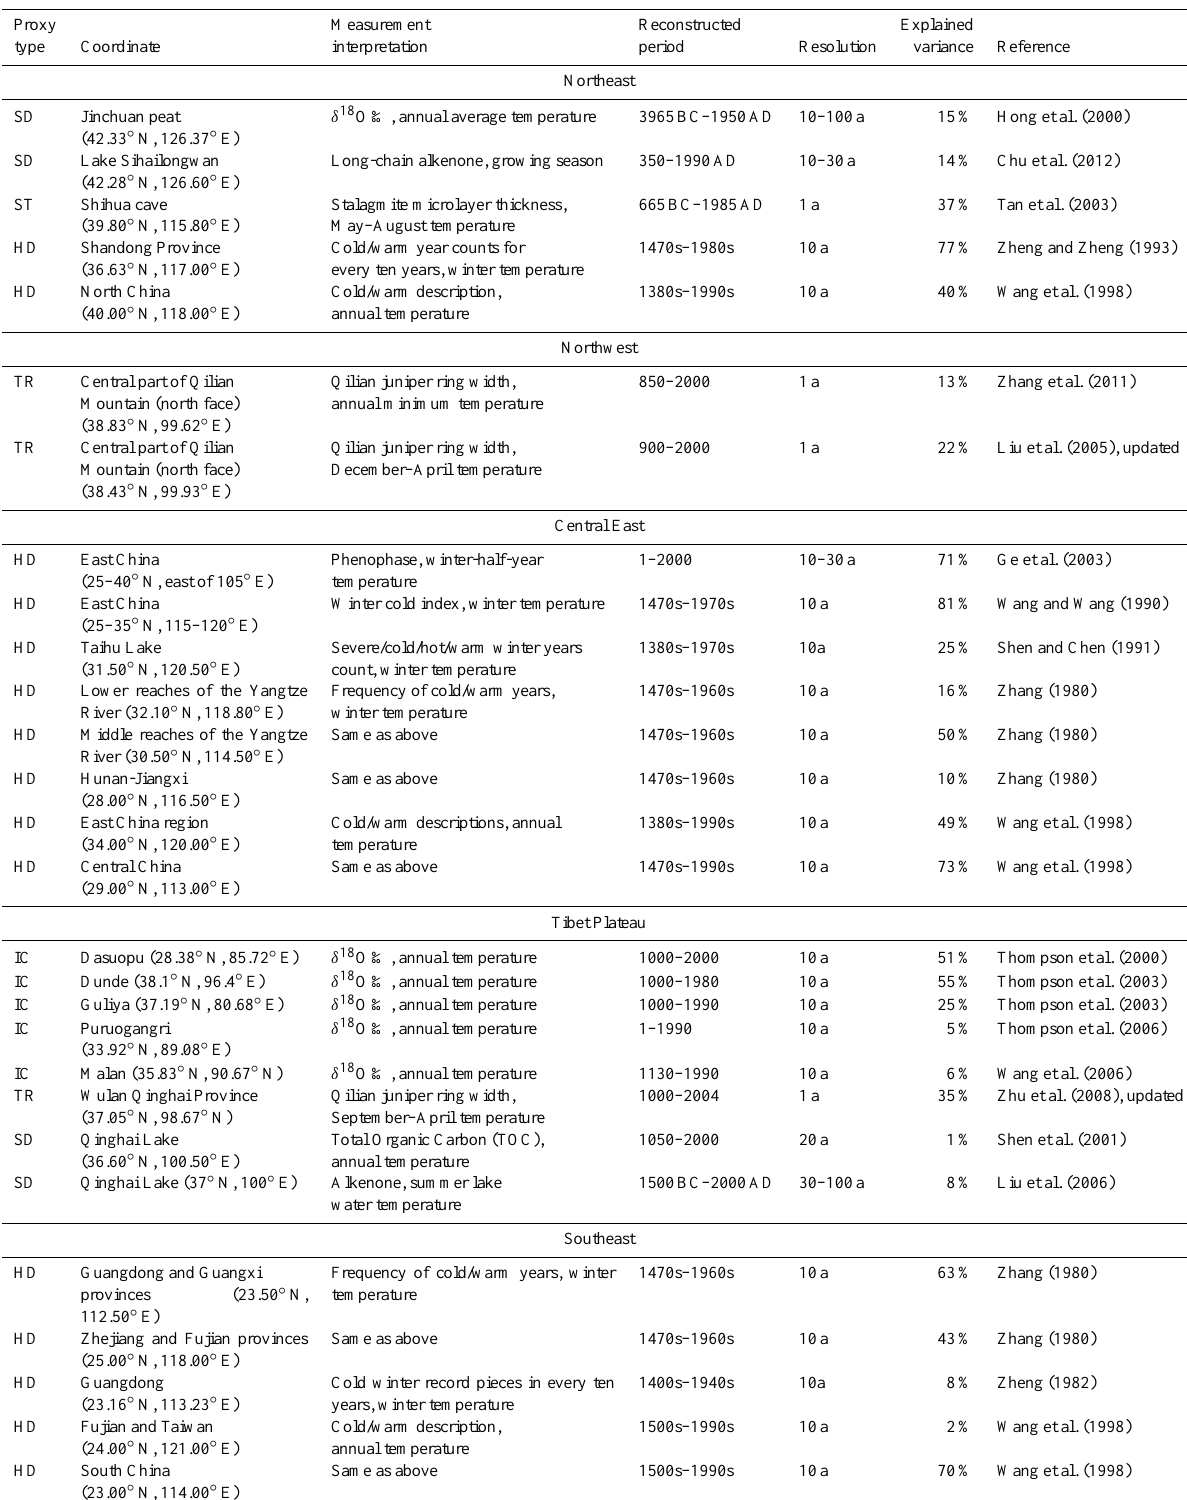
Table 1. Records of the reconstructed temperature proxies shown in Fig. 1 (proxy types: SD, sediments; ST, stalagmites; HD, historical documents; TR, tree rings; IC, ice cores).